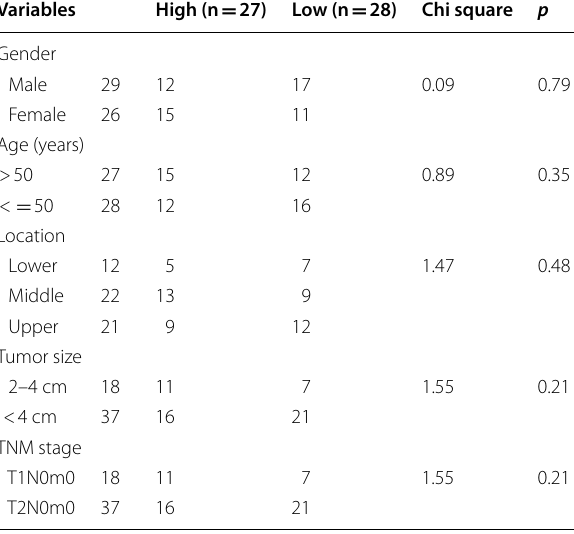
Table 1 Correlation between plasma levels of NCK1-AS1 and patients’ clinical data